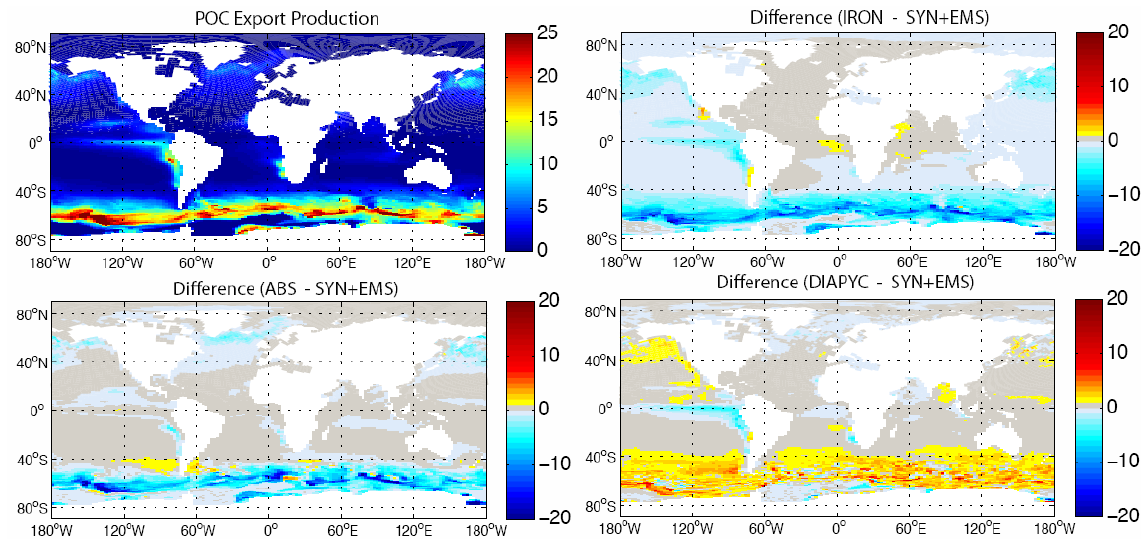
Fig. 18. POC export (molCm − 2 yr − 1 ) for 2007 for SYN+EMS as a reference and differences from this for IRON, ABS, and DIAPYC sensitivity experiments.